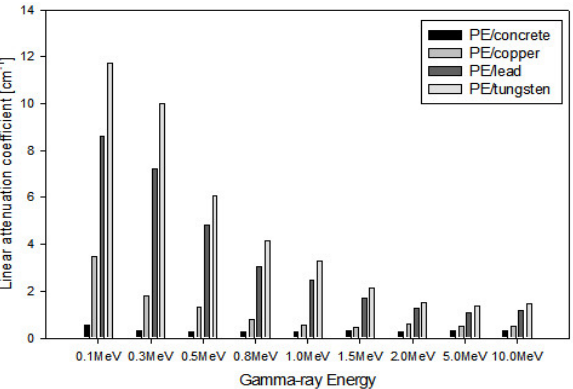
Figure 12. Linear attenuation coefficient of fibrous composite; fiber diameter 0.1128 cm.